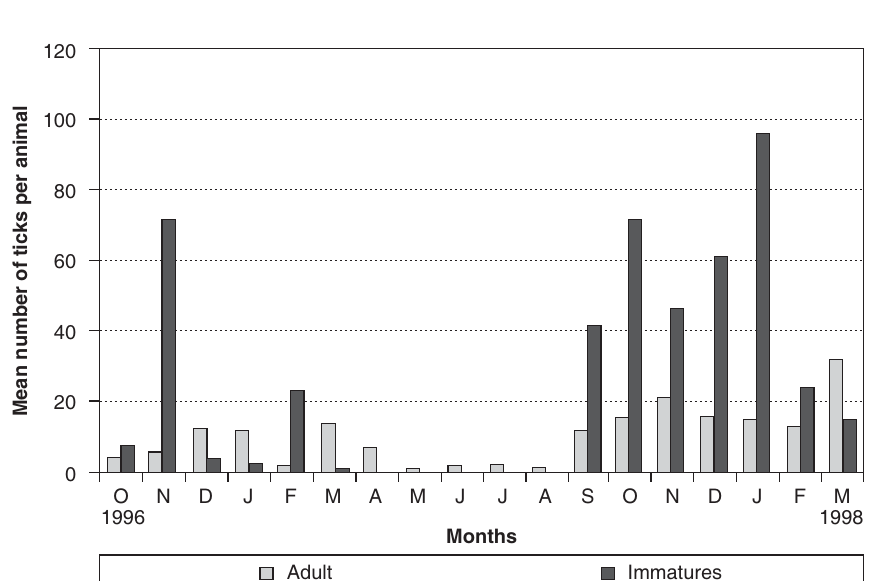
FIG. 1 The monthly activity of adults and imma- ture stages of Hya- lomma a. anatolicum on sheep in El-Akad